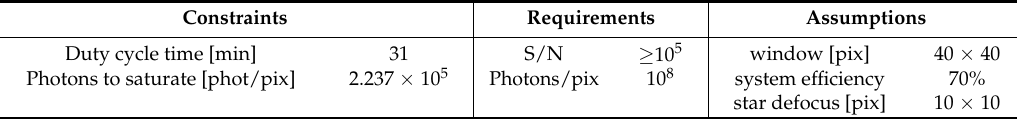
Table 5. Constraints, requirements, and assumptions for the limiting V-magnitude computation.